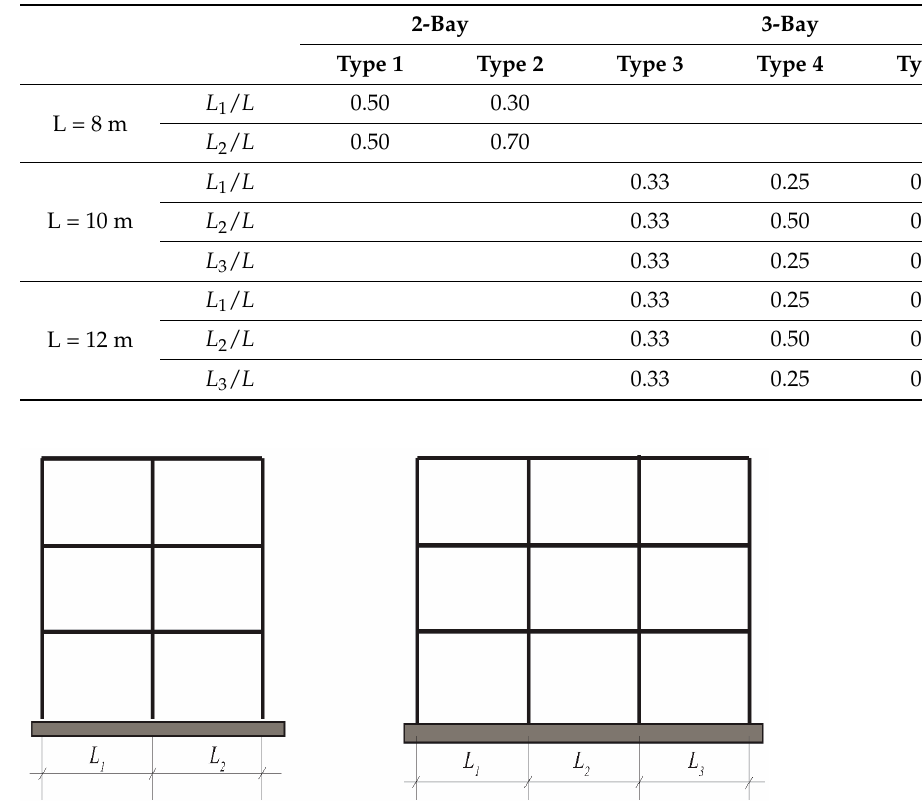
Table 3. Global geometry parameters of the frame typologies in Figure 4.